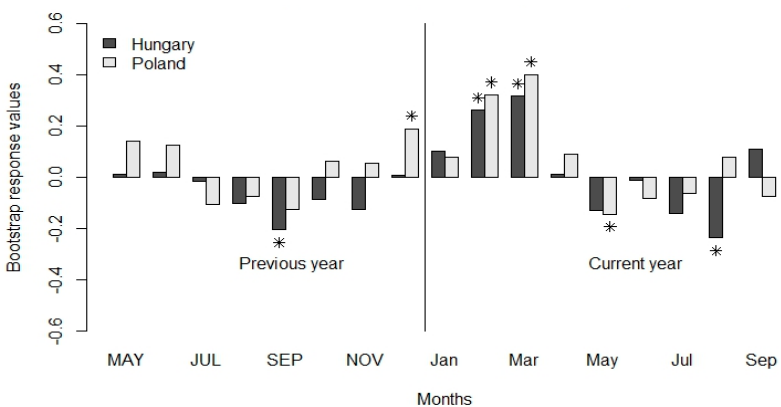
Figure 4. Relationship between growth and temperature in Hungary and Poland. Asterisk (*) significance at p < indicates significance at p < 0.05.